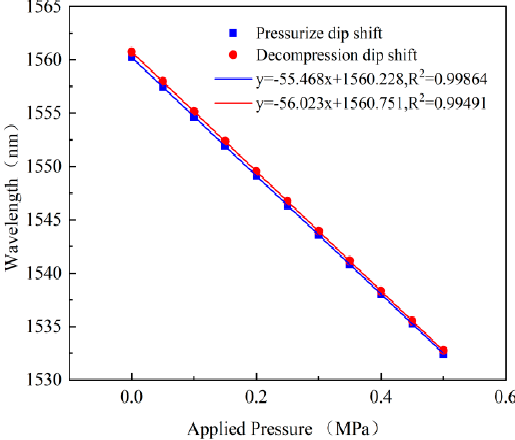
Figure 9. The relationship between the wavelength and the applied pressure. In order to verify the performance of the sensor in a high-temperature environment, sensor#1 was tested from room temperature to high temperature. The relationship between the peak wavelength and the operating temperature is shown in Figure 10. It can be observed that the peak wavelength increased, with the temperature rising due to the high-temperature increases in the Fabry–Perot cavity. The peak shift of the sensor in the temperature range of 25~300 °C is 5.111 nm. The temperature coefficient is 0.01859 nm/°C, which is close to the theoretical results.